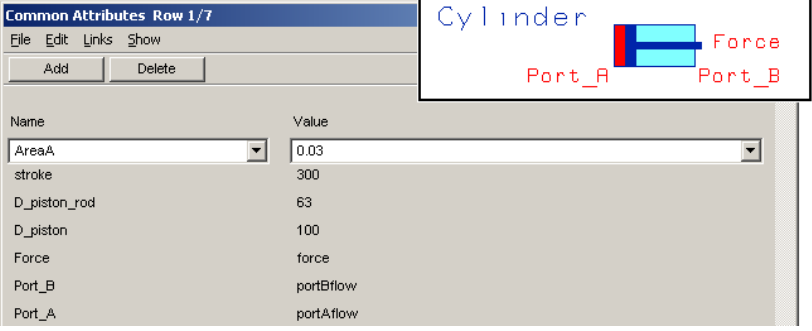
Figure 6. A depiction of a macro with its common attributes in Vertex